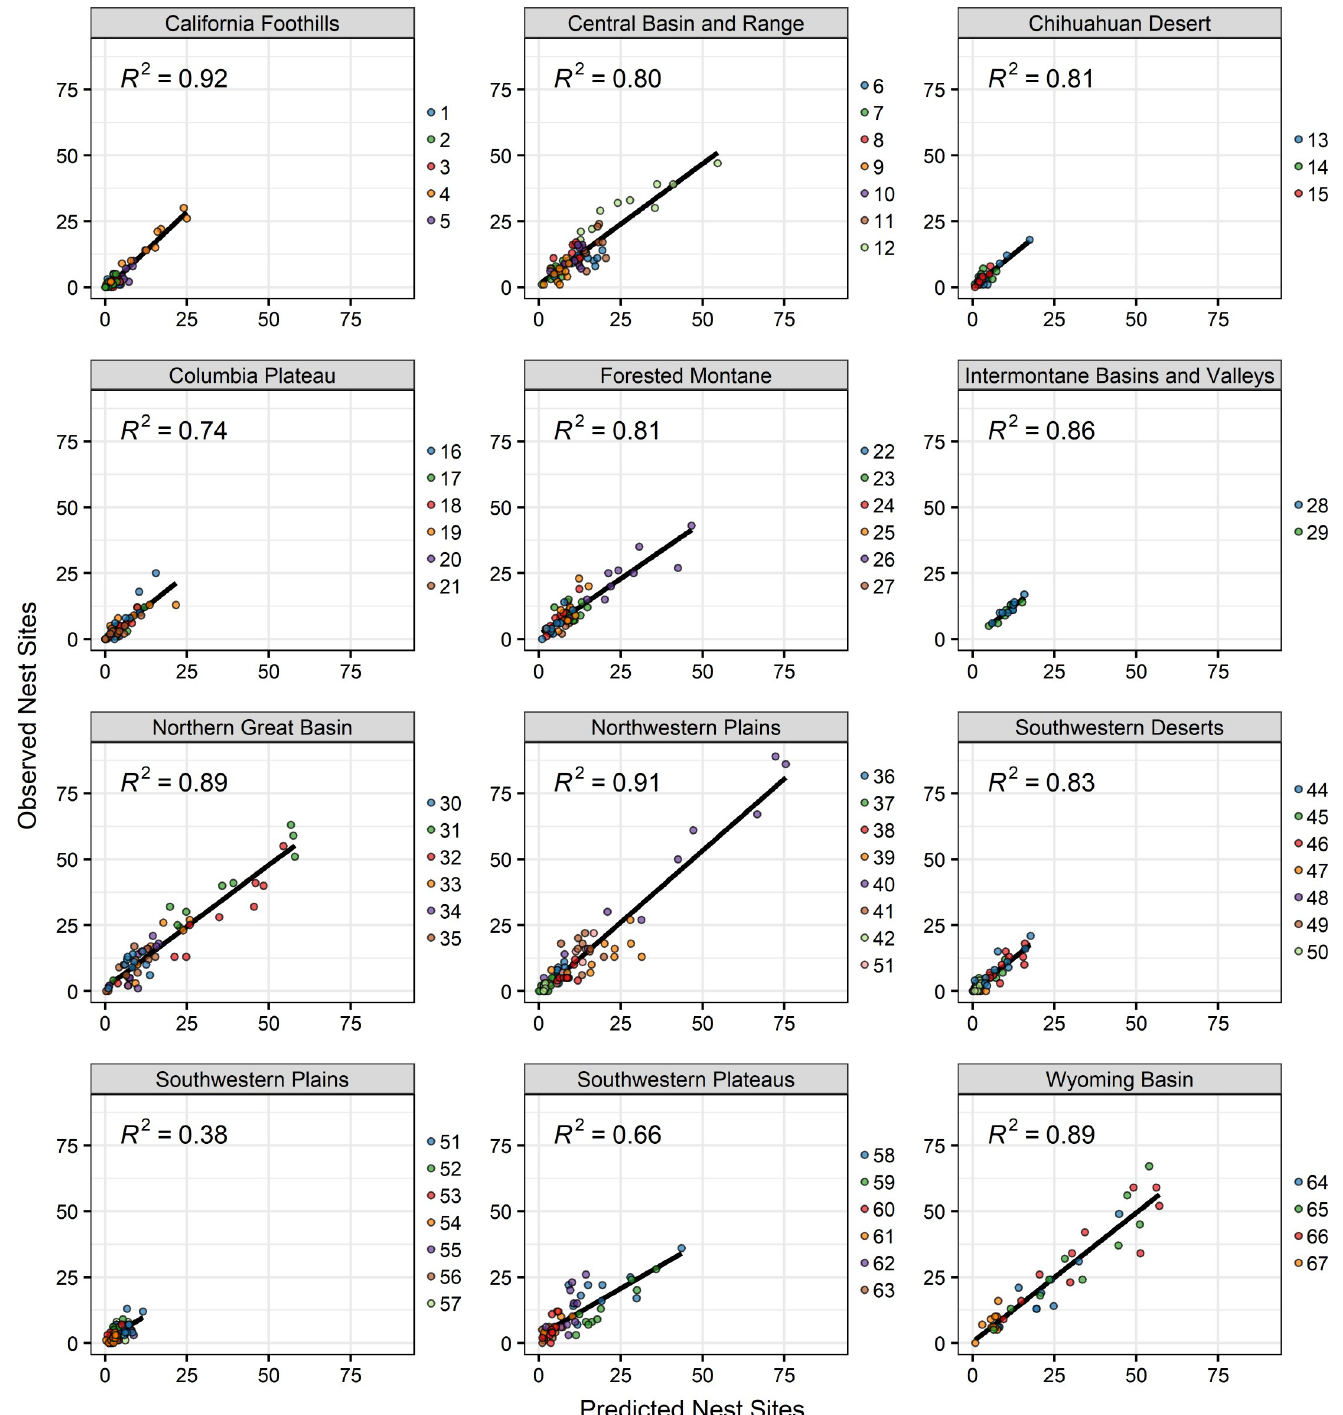
Fig 3. Scatterplots of predicted versus observed number of golden eagle nest sites among 10 RND bins within each modeling region’s sub-regions. Numbers in each region’s plot refer to sub-regions. Sub-region names can be found in S2 Fig.